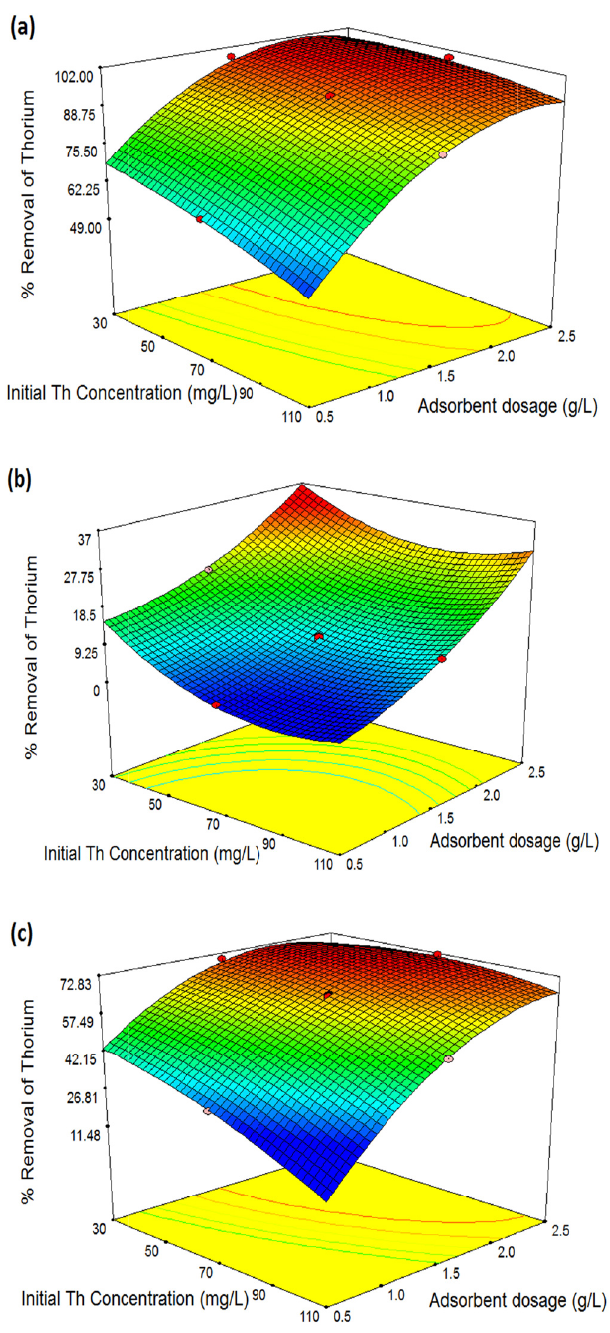
Fig. 3. Three-dimensional plots showing effect of initial Th(IV) ion concentration [mg.L -1 ] and adsorbent dosage [g.L -1 ] on the removal efficiency of Th(IV) using IR-120 (a), IRA-400 (b) and in combination (c), keeping pH